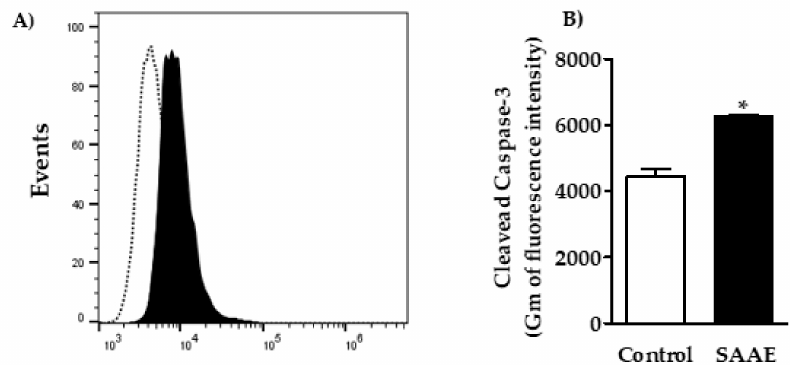
Figure 11. ( A ) Histogram and ( B ) graphical representation of caspase-3 activation in B16F10Nex-2 cells treated with the SAAE (65 µ g/mL). Data are expressed as the mean ± SEM ( n = 3) in duplicates. * p < 0.05 compared with the untreated control